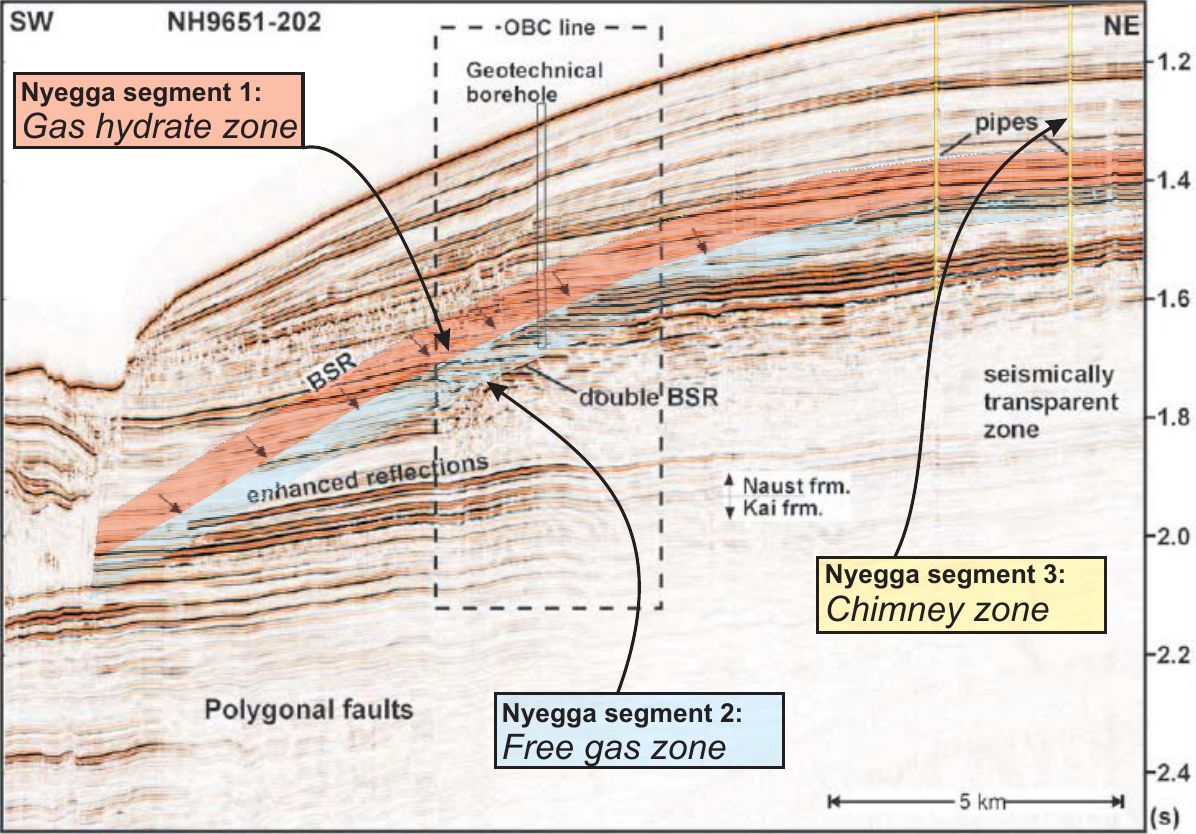
Figure 5. A cartoon sketch of the Nyegga prospect definition based on seismic line NH9651-202, showing its three main segments; (1) The gas hydrate zone, 10–120 m thick; (2) The free gas zone, 20–80 m thick; (3) The chimney zone, on average 200 m wide. The bottom-simulating reflection (BSR) is highlighted with arrows. The BSR is most marked within permeable intervals where the free gas to gas hydrate transition causes a strong and sharp amplitude change. The geotechnical borehole, 6404/5 GB1, has been used to constrain porosity. The polygonal fault system within the underlying Kai Formation provides pathways for fluid and gaseous flow [54]. Figure modified from Bünz and Mienert